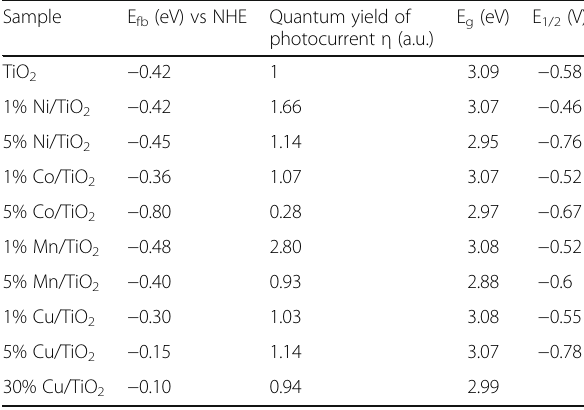
Table 1 Photoelectrochemical characterization of M/TiO 2 films (M – Co, Ni, Mn,